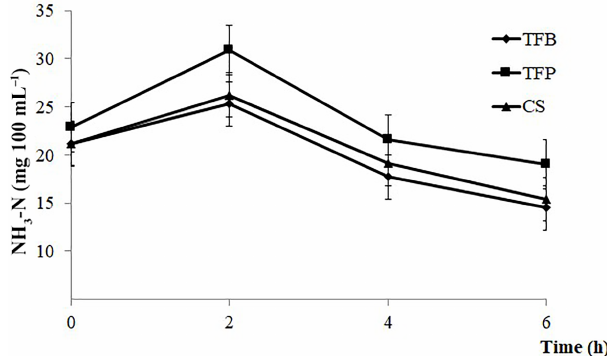
Figure 2. Evolution of ammonia (NH 3 –N) post feeding of ewes according to the type of concentrate (TFB, TFP, and CS) included in the ewes’ ration (1.8kgd − 1 of oat hay + 500gd − 1 of